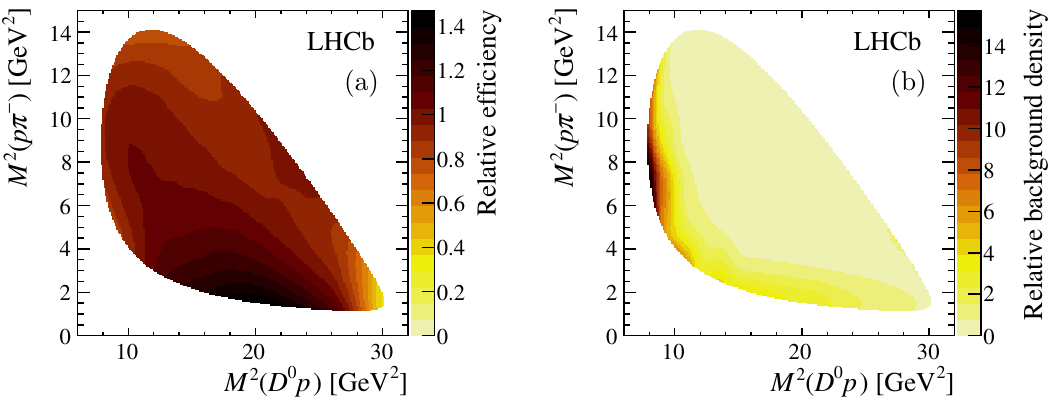
Figure 5 . (a) Relative selection e(cid:14)ciency and (b) background density over the (cid:3) 0 space. The normalisations are such that the average over the phase space is